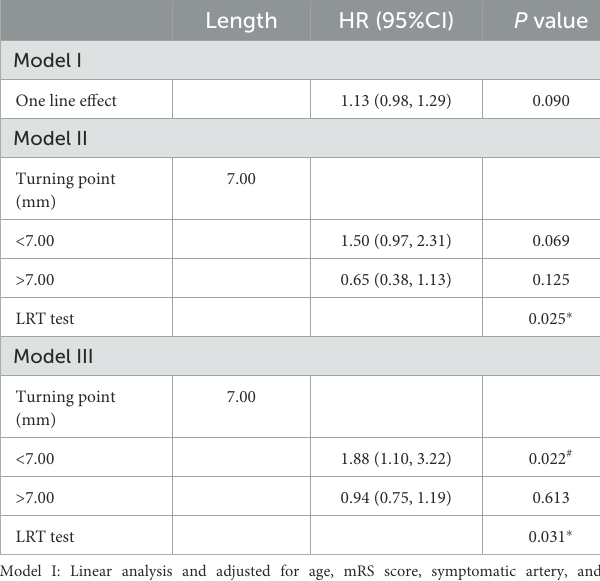
TABLE 3 Threshold effect analysis of the relationship between lesion length and RCI in the overall